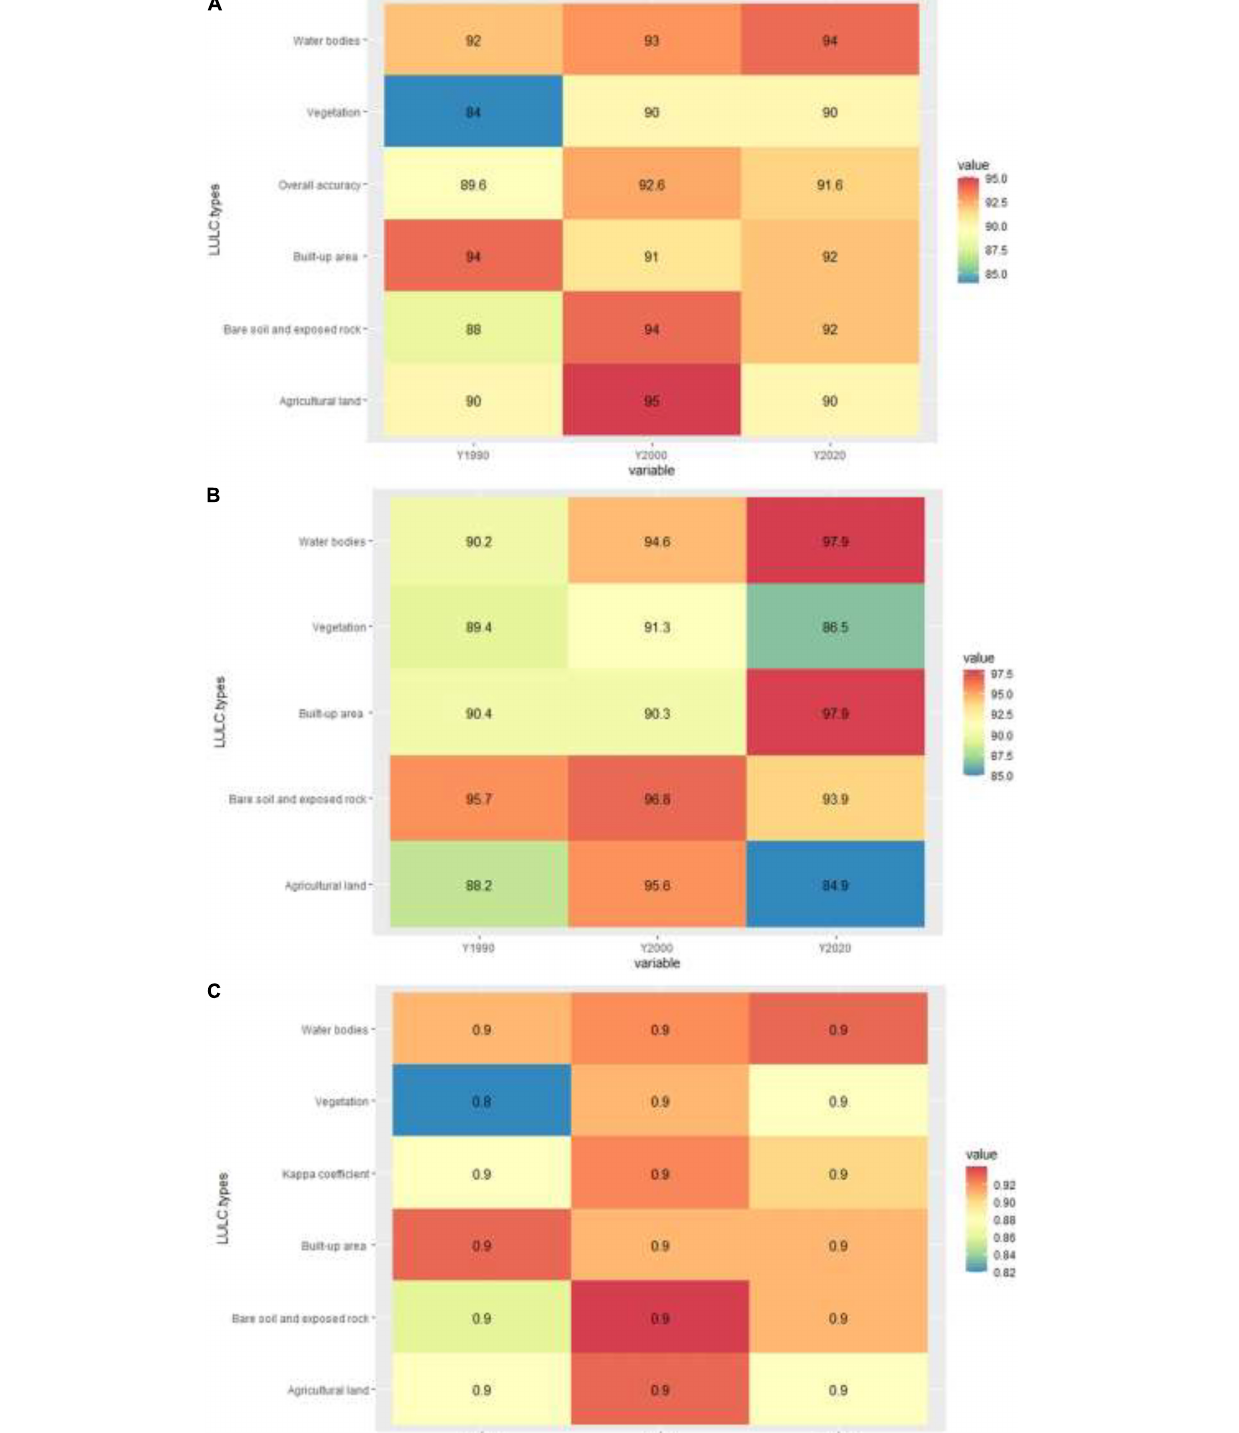
Frontiers in Ecology and Evolution |